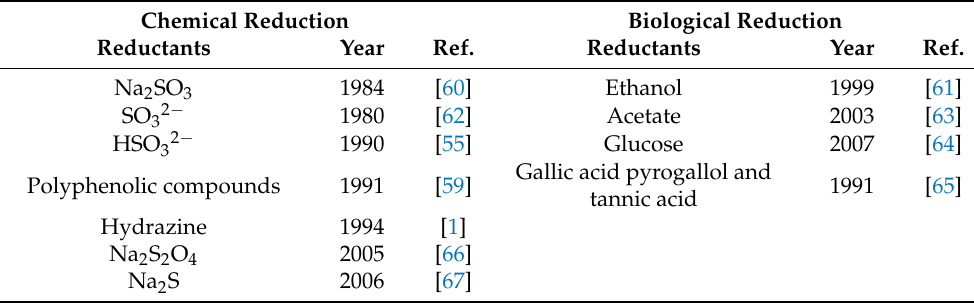
Figure 6. Reduction of NO via formation of N 2 O as an intermediate. 6. Drawback of Wet Scrubbing The absorption and reduction take place under the same conditions (specially pH) so that the recovery of N 2 O is not easy by this technique. Another critical problem is that the solubility of N 2 O in water is 5-fold than that of NO gas, so the separation of N 2 O is not easy [68]. It is one of the stable greenhouse gasses (GHG) and creates a number of prob- lems after emission from NO x treatment plant. N 2 O takes place by tail gas, which is a very serious issue because it is one of the GHG and causes serious problems such as ozone depletion substance (ODS) [69]. The accumulation of N 2 O in the atmosphere is again a